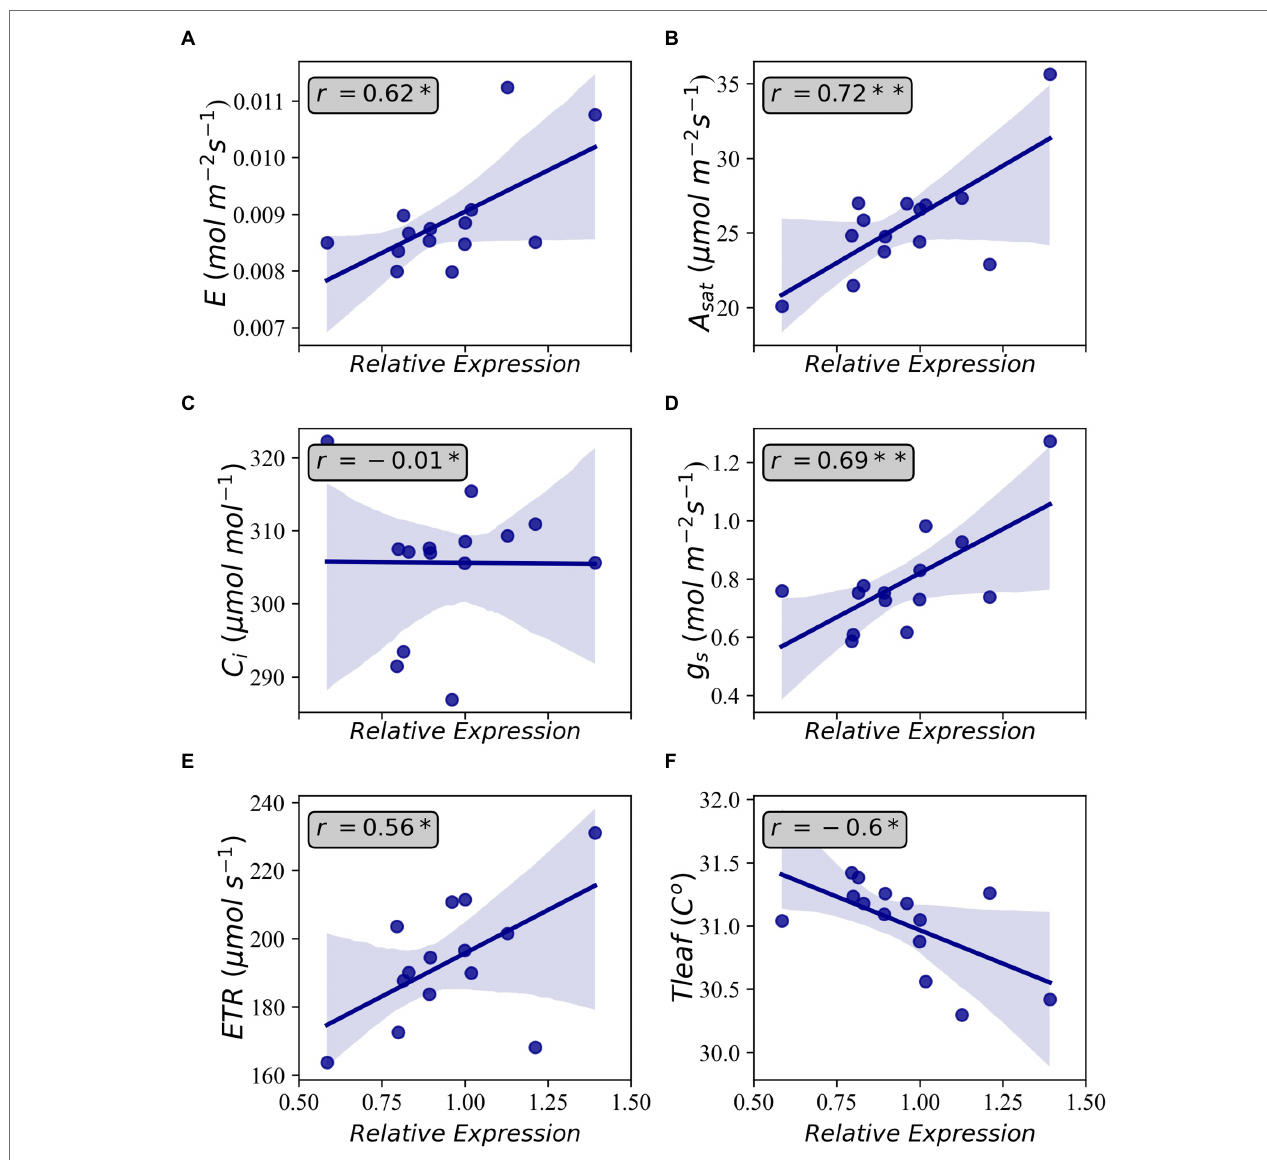
FIGURE 5 | Correlations between relative gene expression of Glyma.17G226700 and Transpiration (A) , light-saturated photosynthesis (B) , intercellular CO 2 concentration (C) , stomatal conductance (D) , electron transfer rate (E) , and leaf temperature (F) . Shaded areas indicate 95 percent confidence intervals. Annotations inside the plots indicate Pearson’s correlation coefficient. Each data point is the average of four observations. * p < 0.05 and ** p <